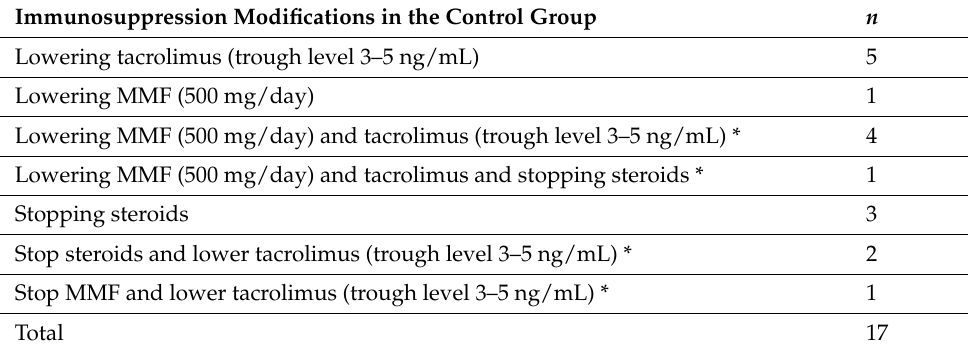
Table 2. Protocols for reducing immunosuppression in the control group. Immunosuppression Modifications in the Control Group n Lowering tacrolimus (trough level 3–5